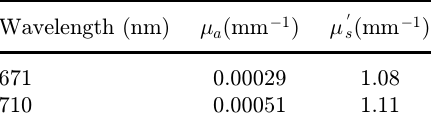
Table 7. Optical properties of the homo- geneous cubic phantom.